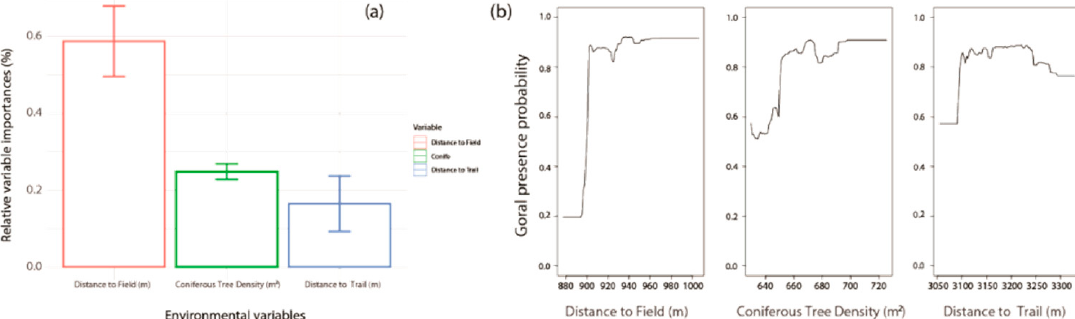
Figure 4. Three selected variables of ensemble model with the algorithms of Random Forest and Boosted Regression Tree: ( a ) relative variable importance (%) and ( b ) relationship between goral presence probabilities and the three relevant factors.